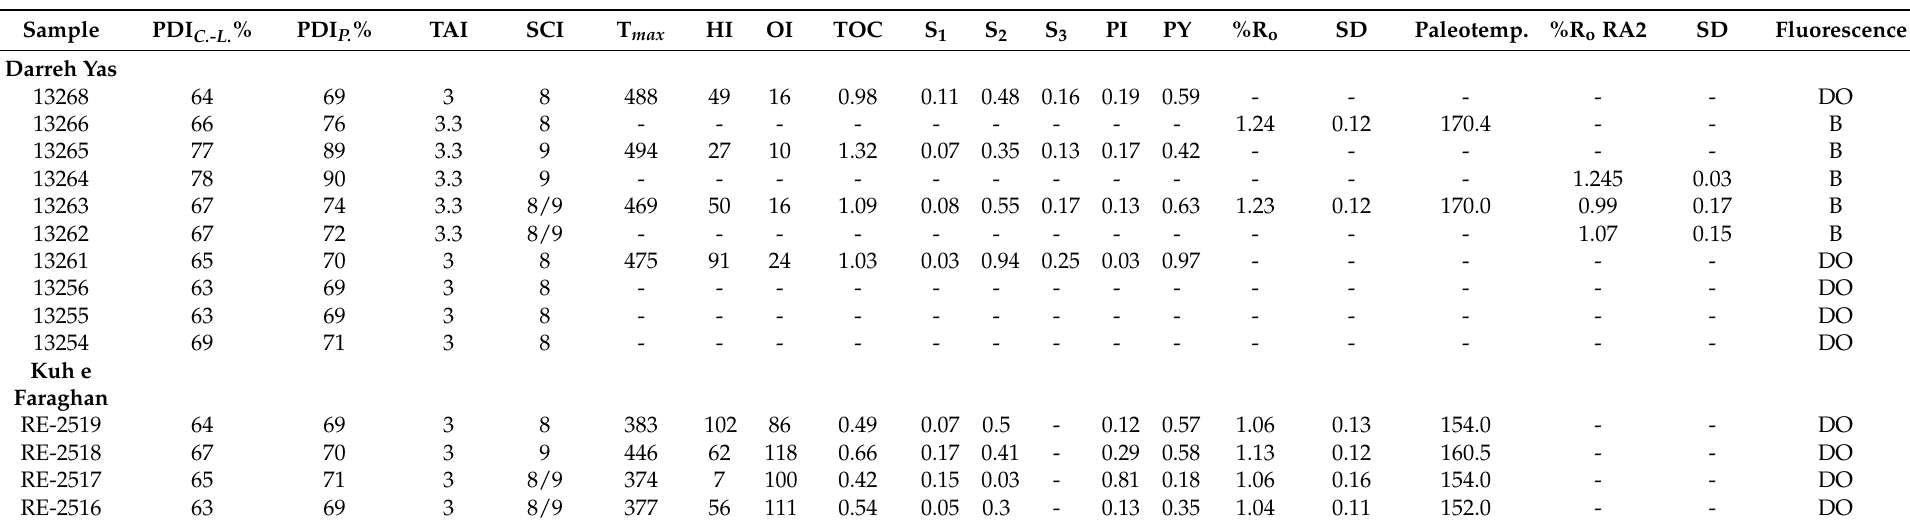
Table 1. Summary of PDI, TAI, SCI, Rock-Eval Pyrolysis, R o , MicroRaman and UV Fluorescence